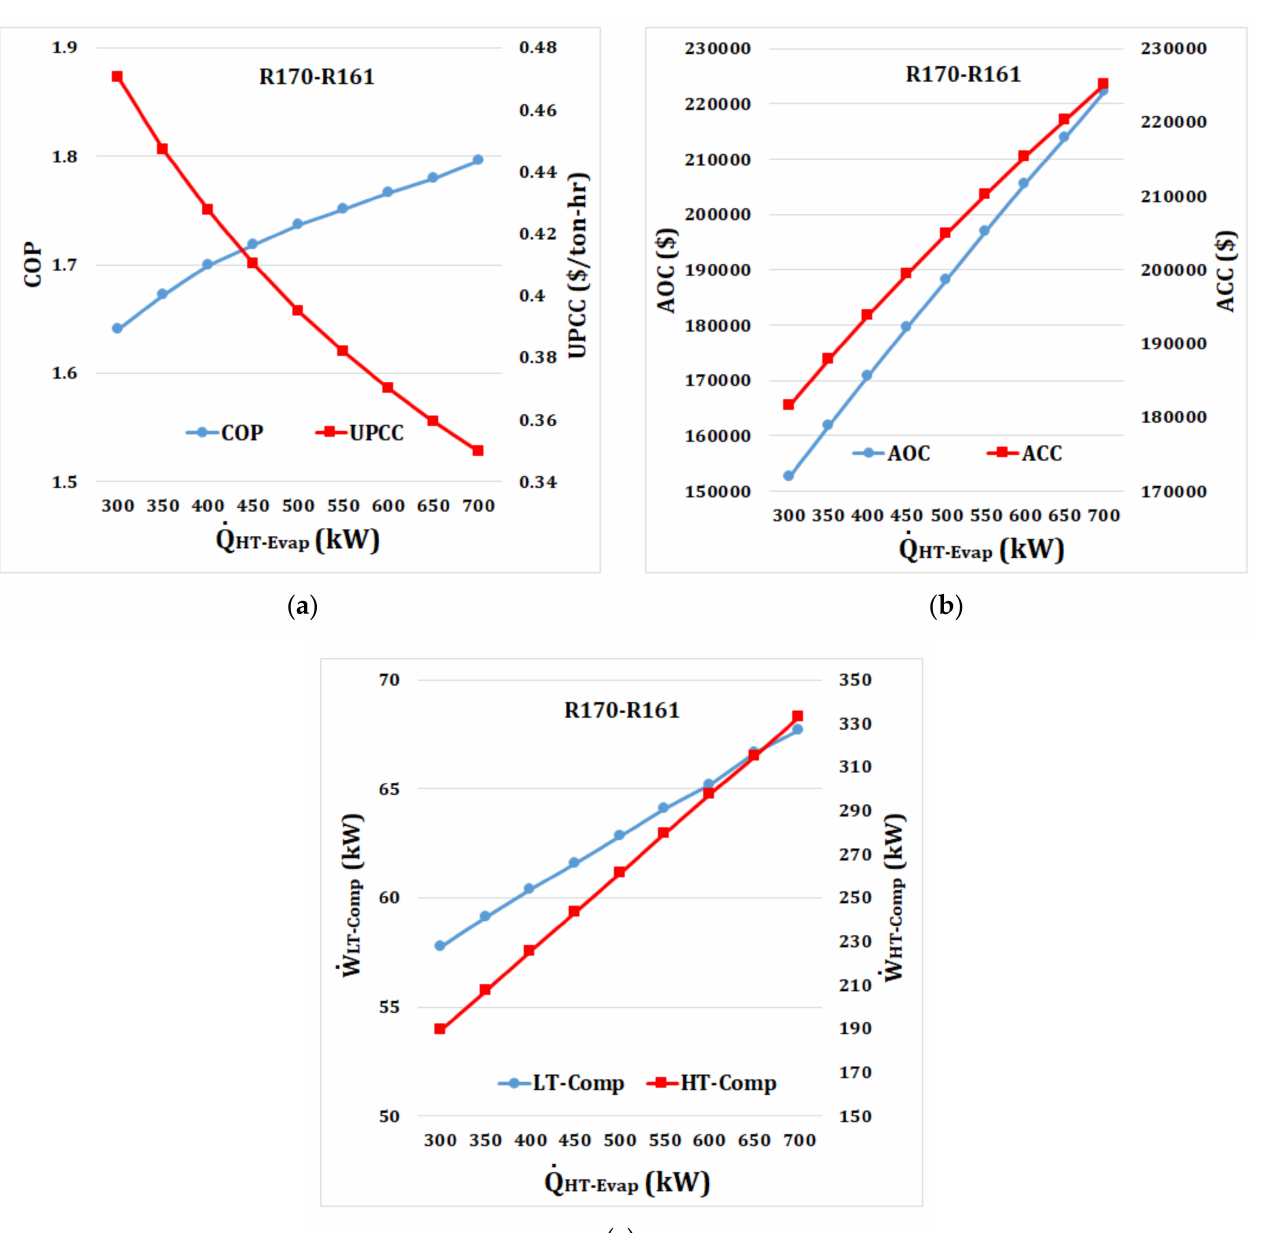
. Q HT − Evap on ( a ) COP and UPCC, ( b ) AOC and ACC, and ( c ) Figure 14. Effect of cycle using R170-R161 refrigerant